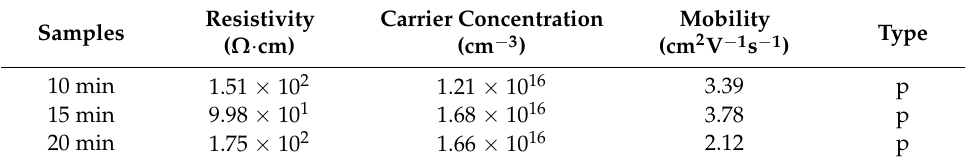
Table 2. The resistivity ( Ω · cm), carrier concentration (cm − 3 ), and mobility (cm 2 v − 1 s − 1 ) of CNZTSSe films were obtained as the selenidation time of 10 min, 15 min, and 20